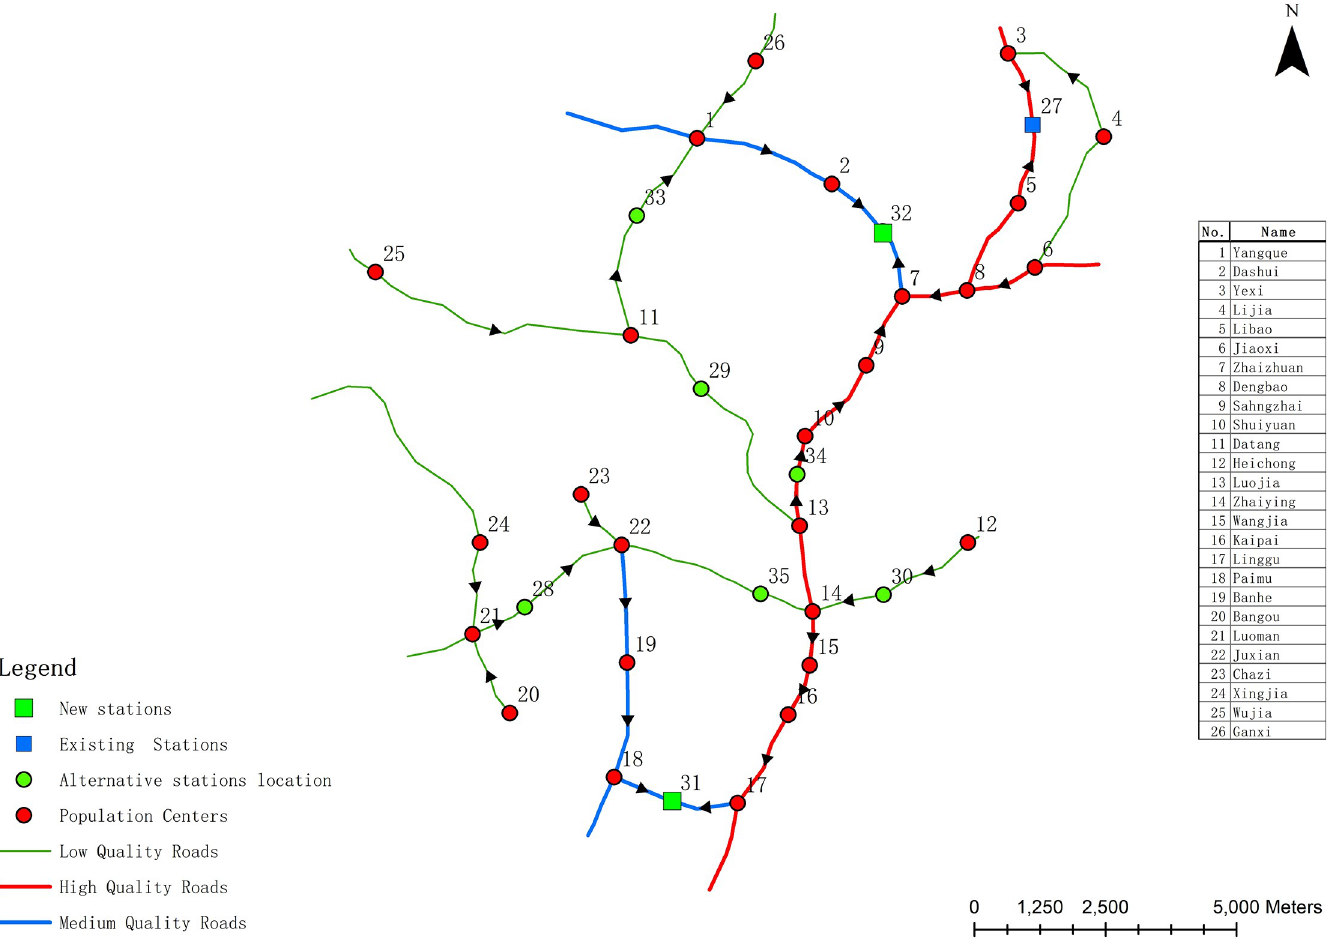
Fig 4. The optimal solutions in Model 1.